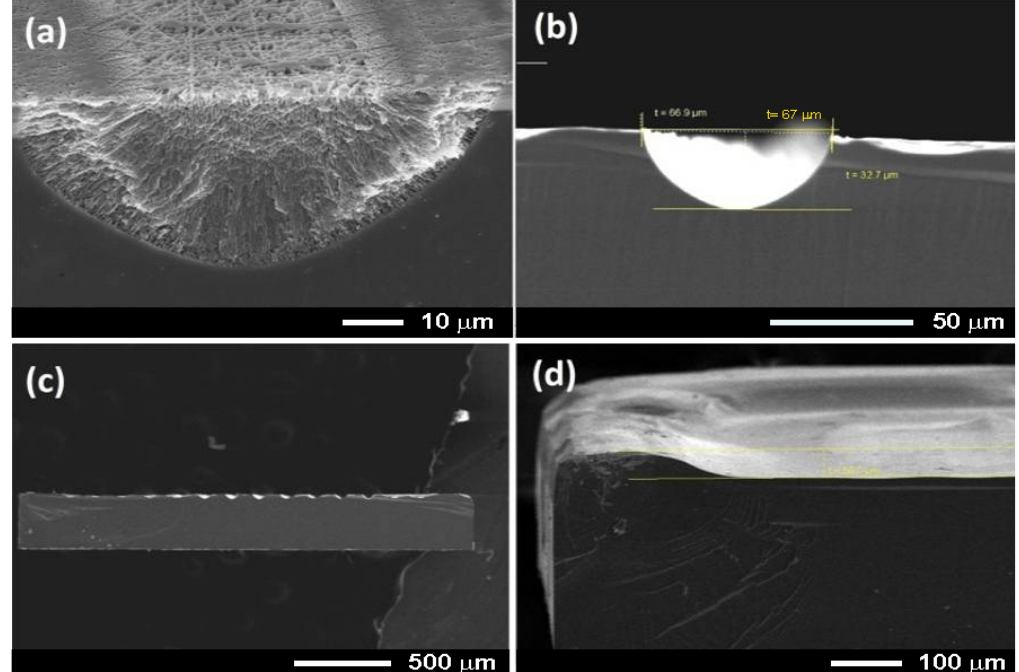
Figure 6. SEM images of the n-InP semiconductor substrate: (a) - after electrochemical etching in NaCl electrolyte for 1 min through opened windows in the photoresist; (b) - the semicircular channel obtained after chemical removal of the porous layer from (a); (c) – array of formed parallel channels on the same chip; (d) - after electrochemical etching for 2 min and chemical removal of the porous